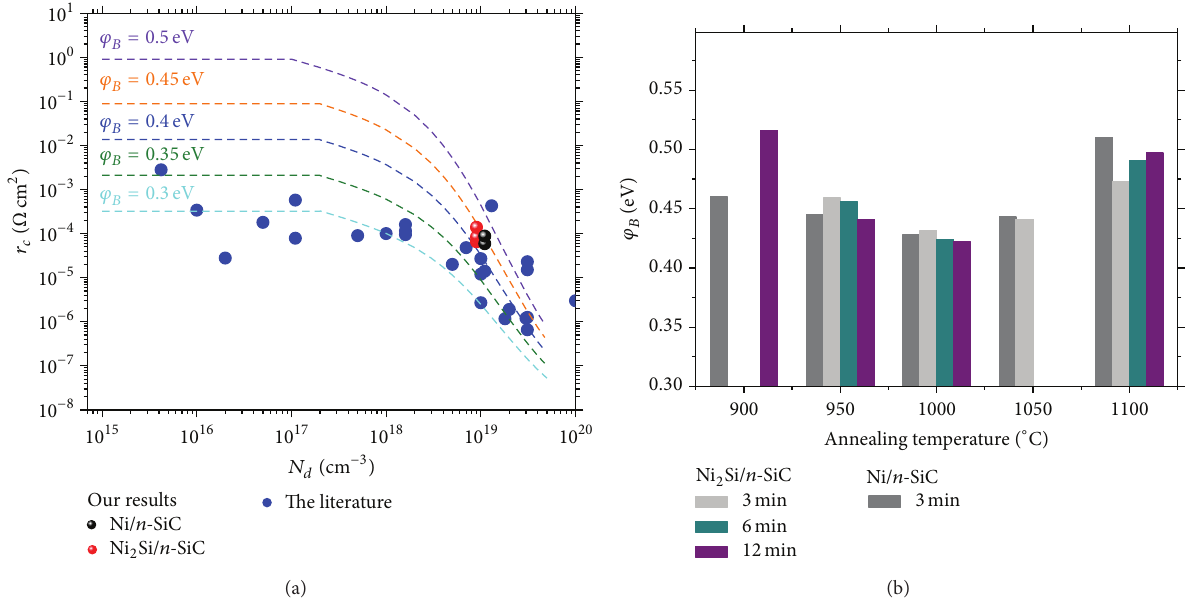
Figure 12: (a) Calculated ohmic contact resistance ( 𝑟 𝑐 ) as a function of the doping concentration ( 𝑁 𝑑 ) of 4H- n -SiC for various barrier heights ( 𝜑 𝐵 ). The lines represent the calculated dependences based on the TE and TFE models. The points represent the experimental data for contacts annealed at 950, 1000, and 1050 ∘ C for 3min as well as some data from [7–47]. (b) Effective barrier height ( 𝜑 𝐵 ) of Ni and Ni 2 Si ohmic contacts to n -type ( ∼ 1 × 10 19 cm −3 ) 4H-SiC epiwafers versus annealing temperature/time.